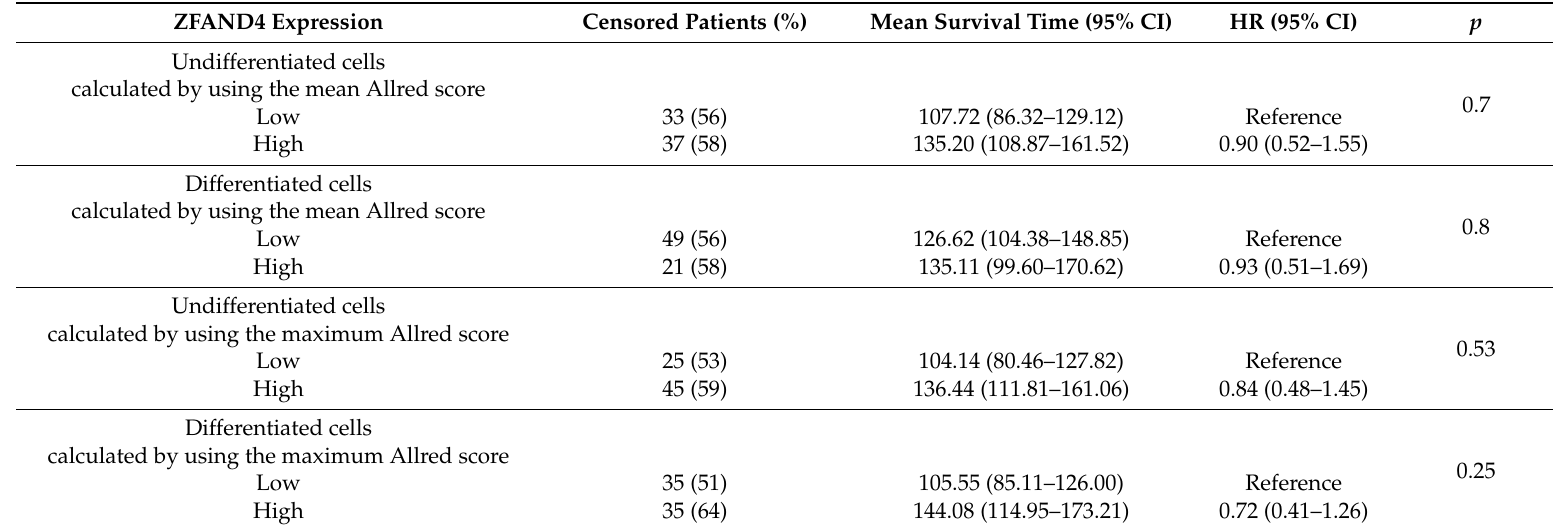
Table 4. Univariate Kaplan-Meier and Cox analysis to assess the association of ZFAND4 expression on disease-specific survival in oral squamous cell carcinoma